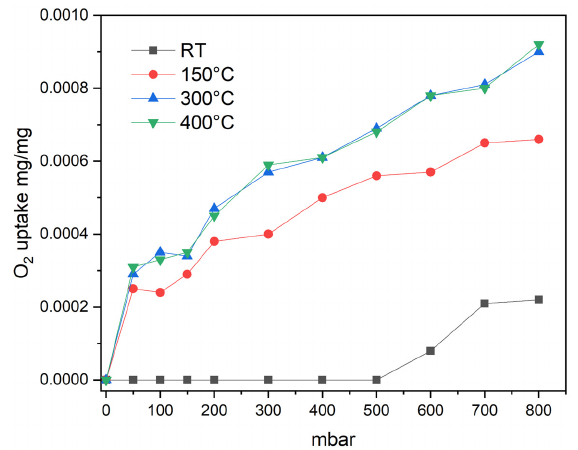
Figure 5. Microgravimetric O 2 uptake with NPW6-1000 activated in vacuo at RT (nearly 30 °C), 150, 300, and 400 °C.